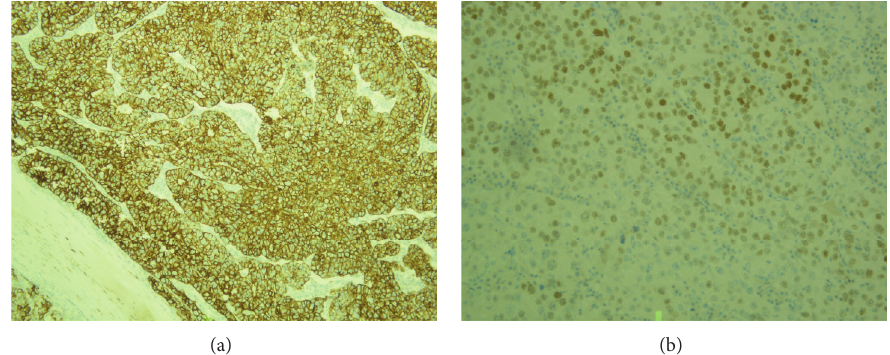
Figure 3: Microphotograph showing a section of the abdominal wall mass with cytokeratin 7 (a) and oestrogen receptor (b) positive